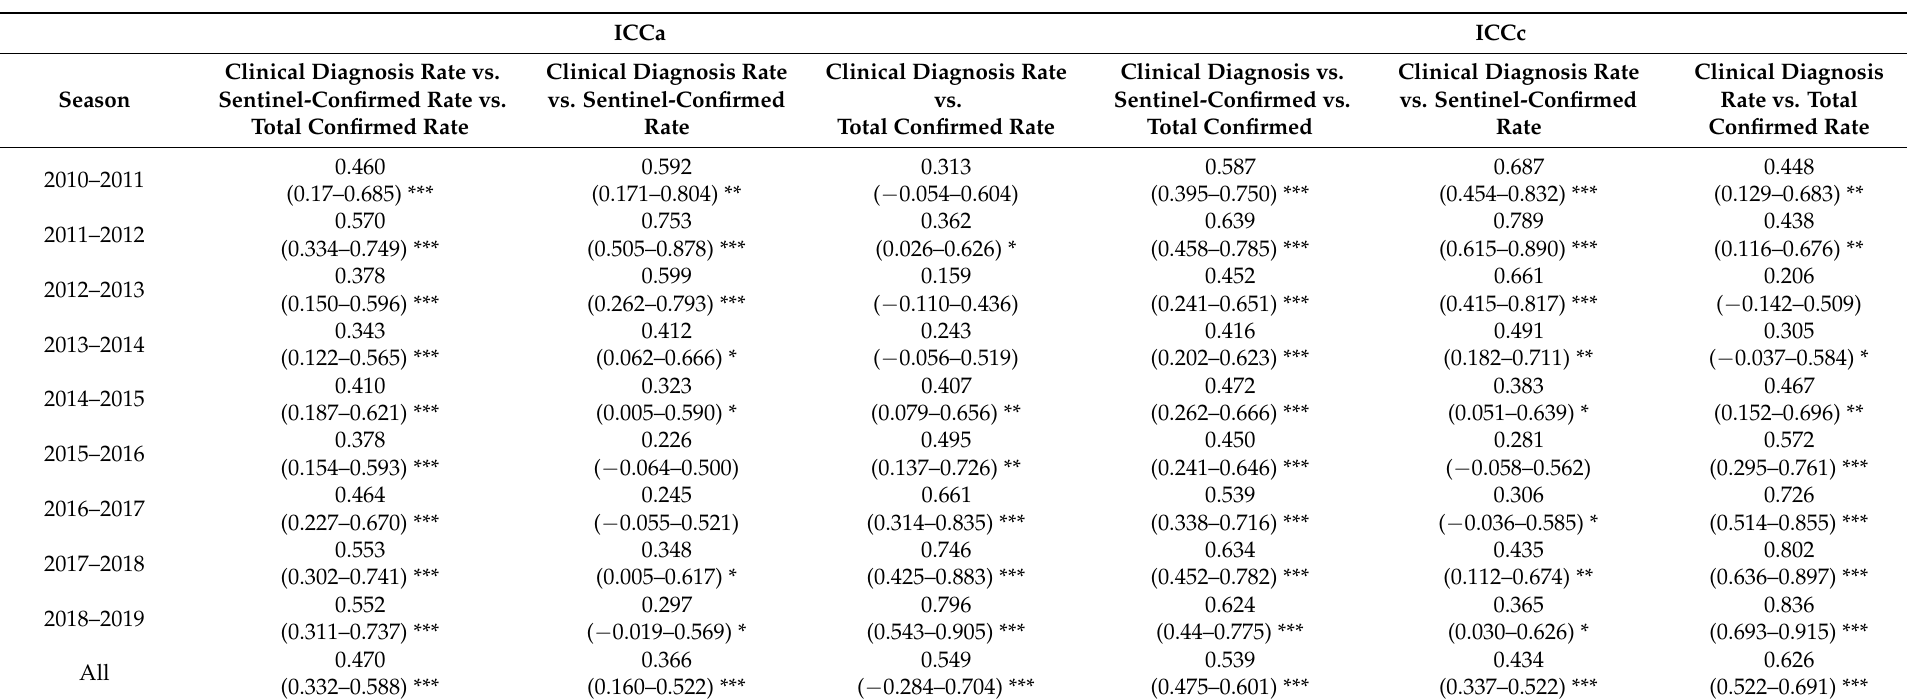
Table 1. Intraclass correlation coefficient of absolute agreement (ICCa) and consistency (ICCc) with their confidence intervals 95% among the clinical diagnostic, sentinel-confirmed, and total confirmed